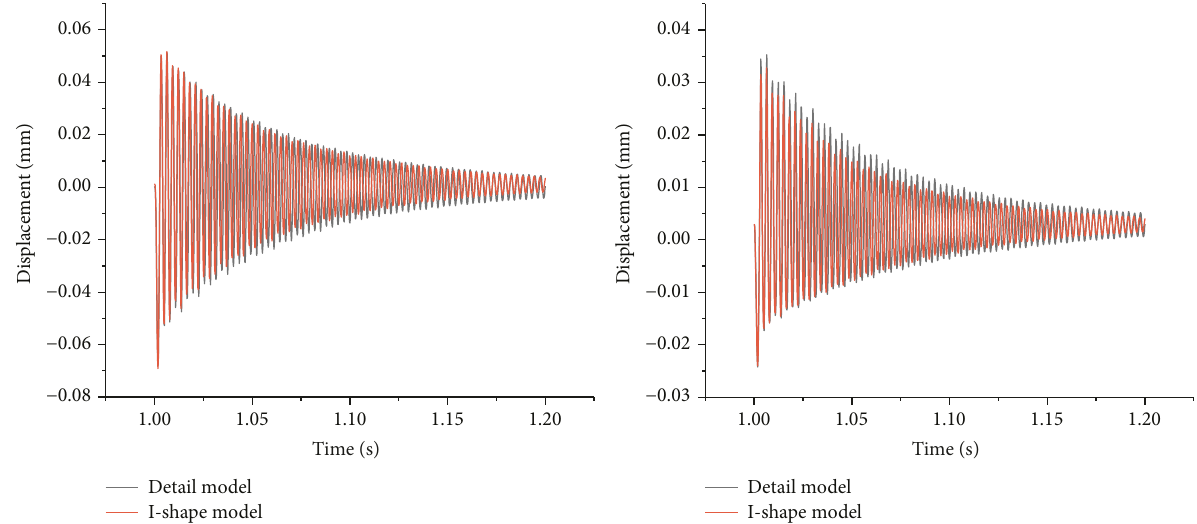
Figure 12: X and Y direction displacement response of the connection structure under 1500N impact load on the